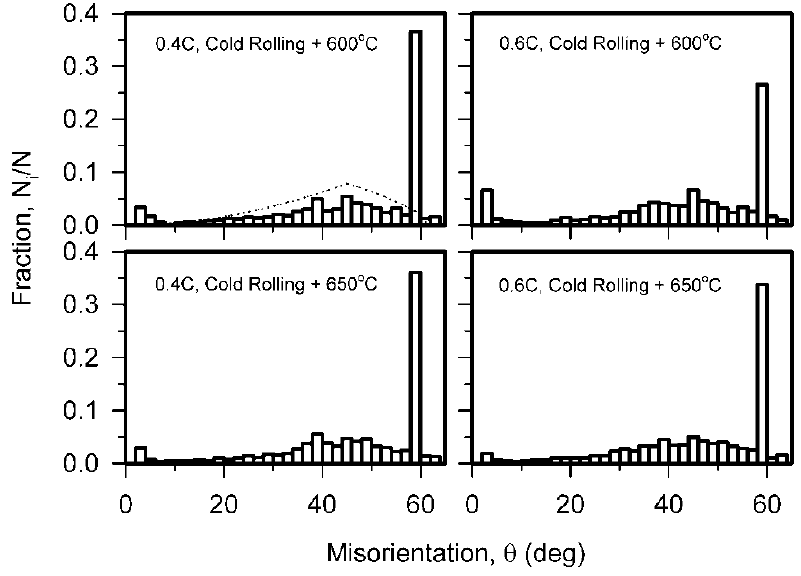
Figure 4. Grain/subgrain boundary misorientation distribution in Fe-0.4C-18Mn and Fe-0.6C-18Mn steels (0.4C and 0.6C, respectively) subjected to cold rolling and annealing at indicated temperatures. The dotted line indicates random misorientation distribution.